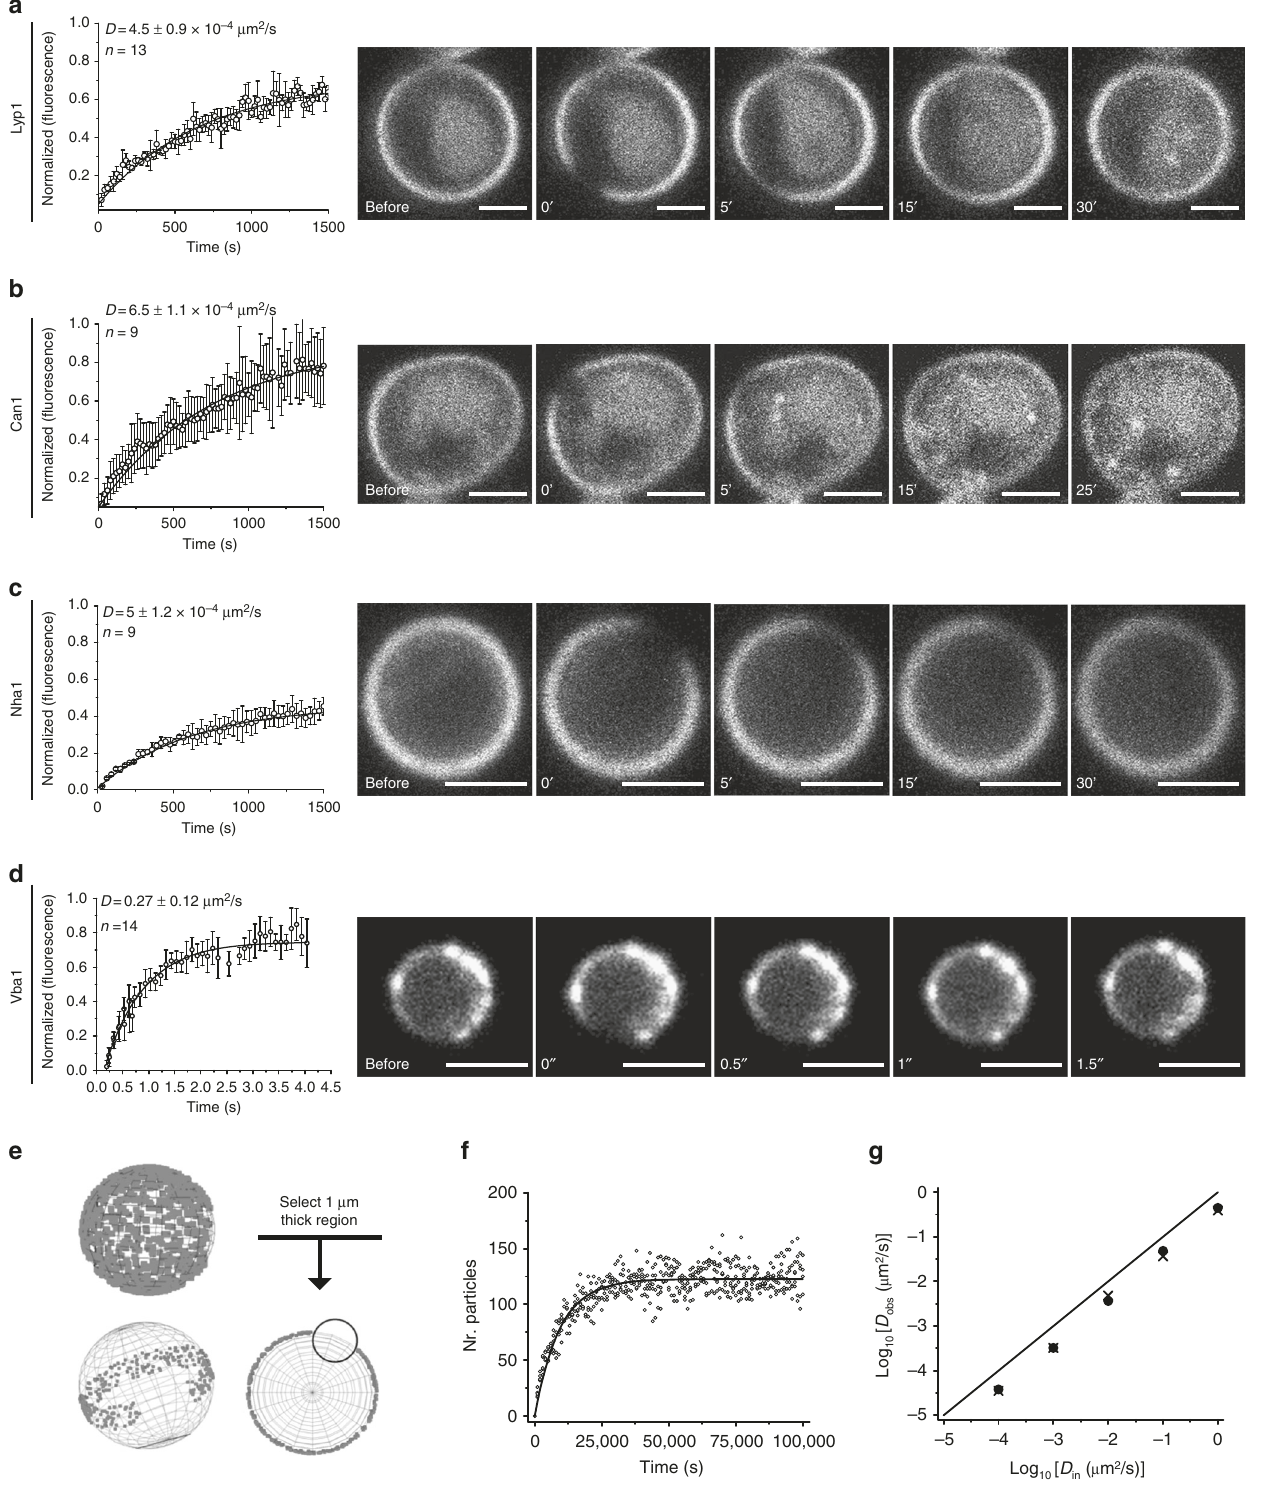
Fig. 3 FRAP measurements to probe long-range diffusion. Normalized fl uorescence recovery of YPet-tagged transporters expressed from a plasmid in the respective endogenous knockout strain: Lyp1-YPet (immobile fraction: 0.35) ( a ), Can1-YPet (immobile fraction: 0.15; n = 9) ( b ), Nha1-YPet (immobile fraction: 0.55; n = 9) ( c ), and Vba1-YPet (immobile fraction: 0.10; n = 14) ( d ). Confocal images of cells before and after photobleaching at different time points are shown in the right panels. Scale bars represent 2 µ m; standard deviations and number of cells analyzed ( n ) are given in the graphs. e Spherical cell model used for simulation of Brownian diffusion as observed in a FRAP experiment. Photo-bleached region of 2 µ m width and 1 µ m thick. f Recovery of the particles in the bleached region (empty dots) and exponential fi tting of the data (black line) are shown. g Comparison of input with observed diffusion coef fi cients for FRAP simulations. Every point indicates a separate simulation. The width and height of the bleached region are 2 and 2 µ m, respectively. The black line represents the function x = y . All proteins were under overexpressed conditions; n represents the number of cells and error bars represent the standard